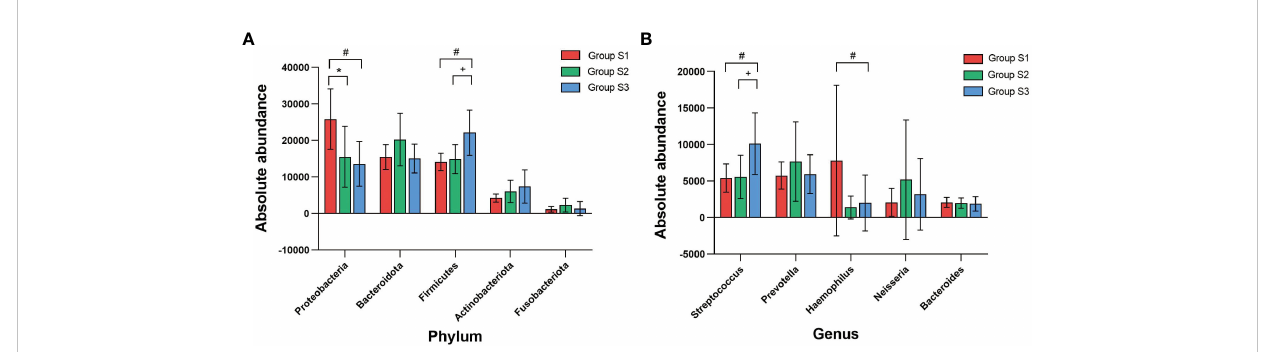
FIGURE 7 Correlation analysis between BMI and absolute abundance of core bacterial OTUs (A) Comparison of the absolute abundance of core OTUs at the phylum level between BMI groups. (B) Comparison of the absolute abundance of core OTUs at the genus level between BMI groups. (K-W test, # : P <0.05, there was a signi fi cant difference between S3 and S1 in absolute abundance; *: P <0.05, there was a signi fi cant difference between S2 and S1 in absolute abundance; + : P <0.05, there was a signi fi cant difference between S3 and S2 in absolute abundance).